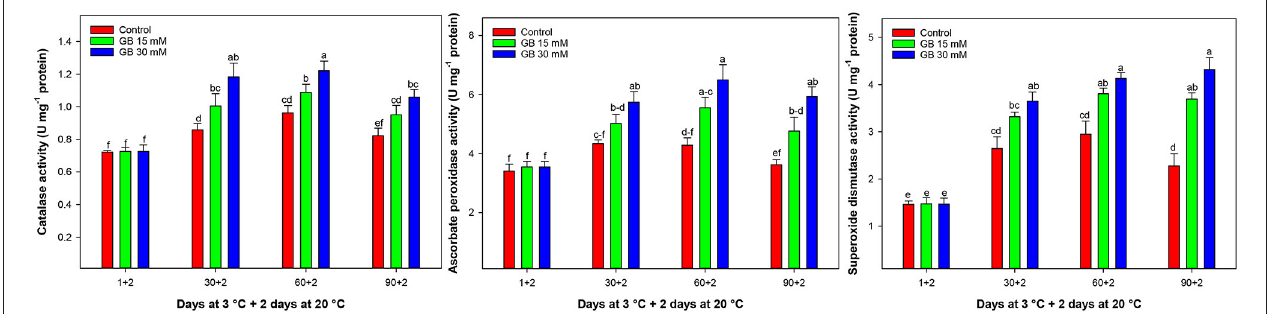
FIGURE 6 | Changes in catalase (CAT), ascorbate peroxidase (APX), and superoxide dismutase (SOD) activities in control and GB-treated of “Moro” blood orange at 3 ◦ C. Different letters and vertical bars show significant difference ( p < 0.05) and standard errors ( ± SE) of means, respectively.